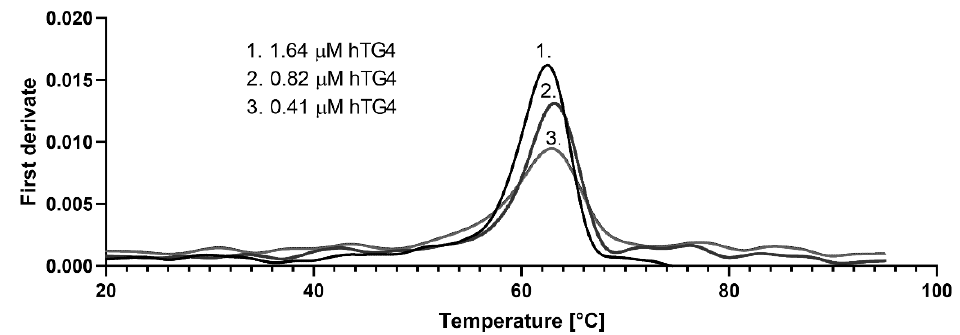
Figure 3. Thermal stability of recombinant hTG4 protein. Nano differential scanning fluorimetry was used to determine Tm values, demonstrating the melting scan by the first derivate versus temperature applying 1.64, 0.82 and 0.41 µM hTG4 protein.